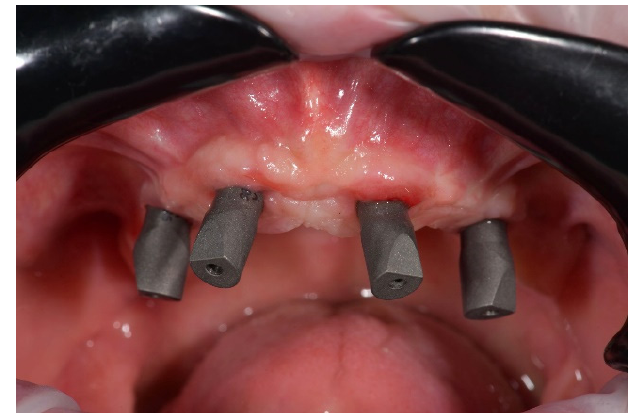
Figure 17. Scan abutments for multi abutments in place.